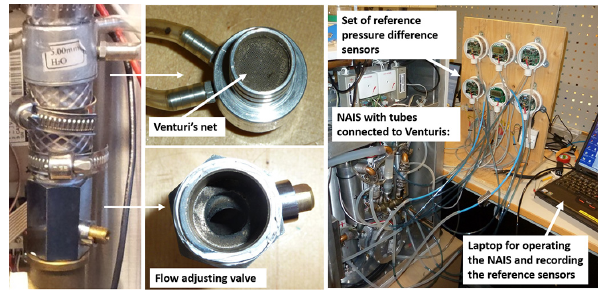
Figure 5. On the left: a dirty Venturi tube and its net, and a dirty flow adjustment valve in a close-up from the NAIS operated in Marikana, South Africa. Both were required to be cleaned well before the flow verification. On the right: an example of a set-up for flow checks with external pressure difference sensors, which are connected to the 5 Venturi tubes to record all the values simultaneously, including the pressure difference over the